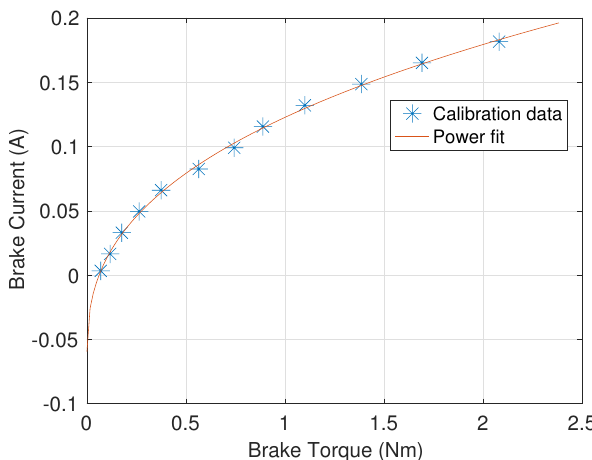
Figure 2. Torque–current relationship of the